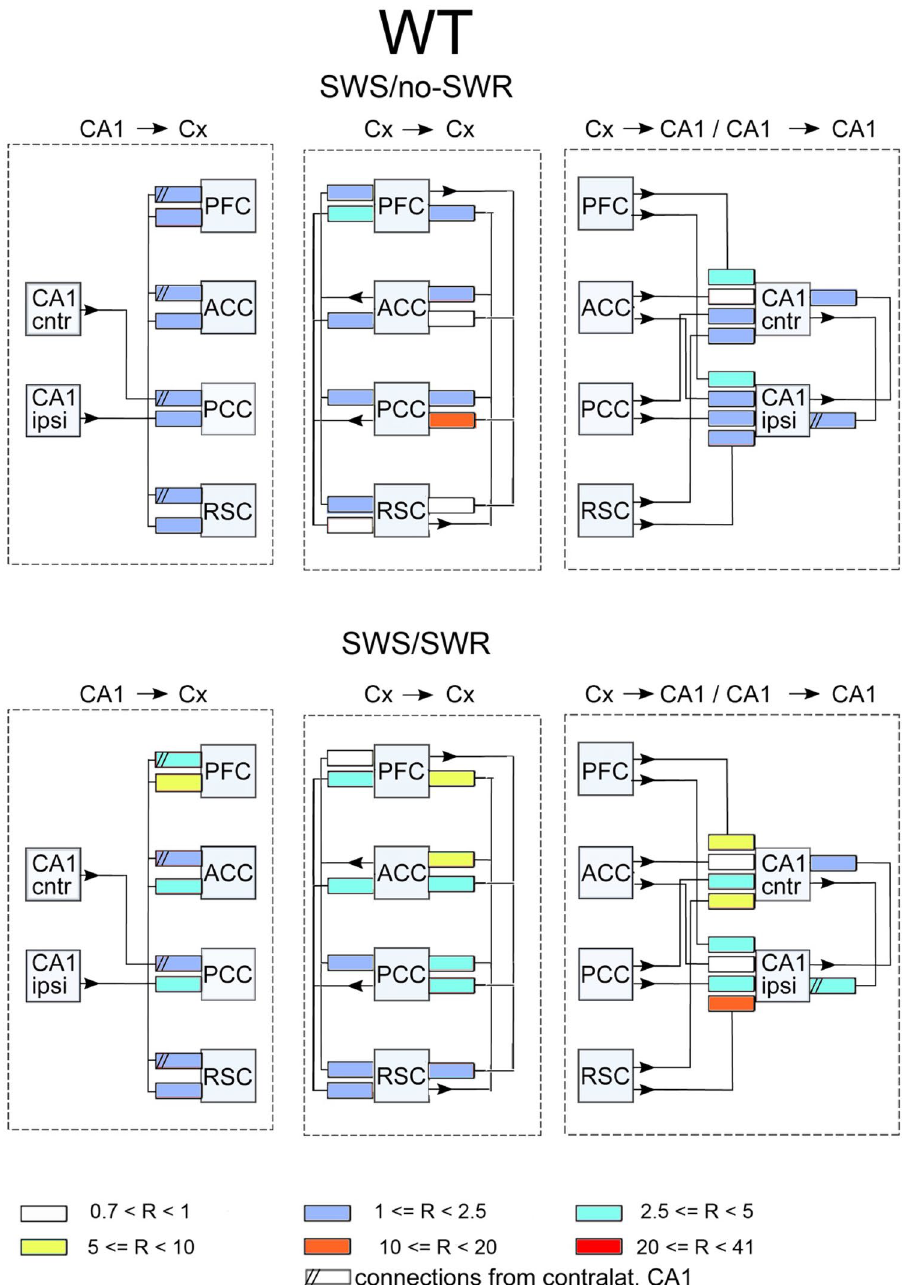
Figure 6. The ratios of coupling for WT mice after/before learning for SWS/no-SWR episodes (upper picture) and for SWS/SWR episodes (lower picture). Shown are (from the left to the right): coupling ratios from CA1 to cortex, between cortices, from cortices to CA1, and between two CA1. The color coding of values of the ratios at the bottom of the